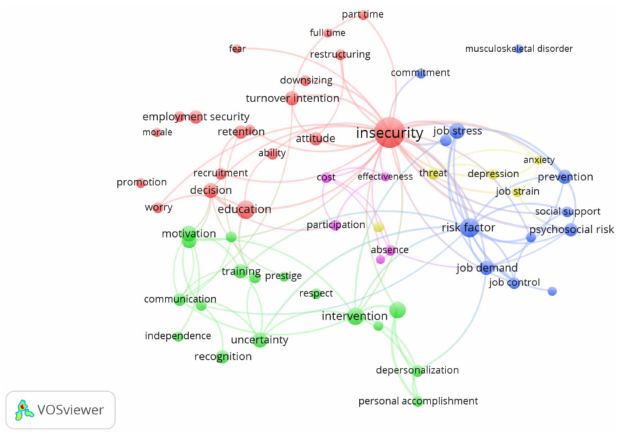
Figure 4. Topics